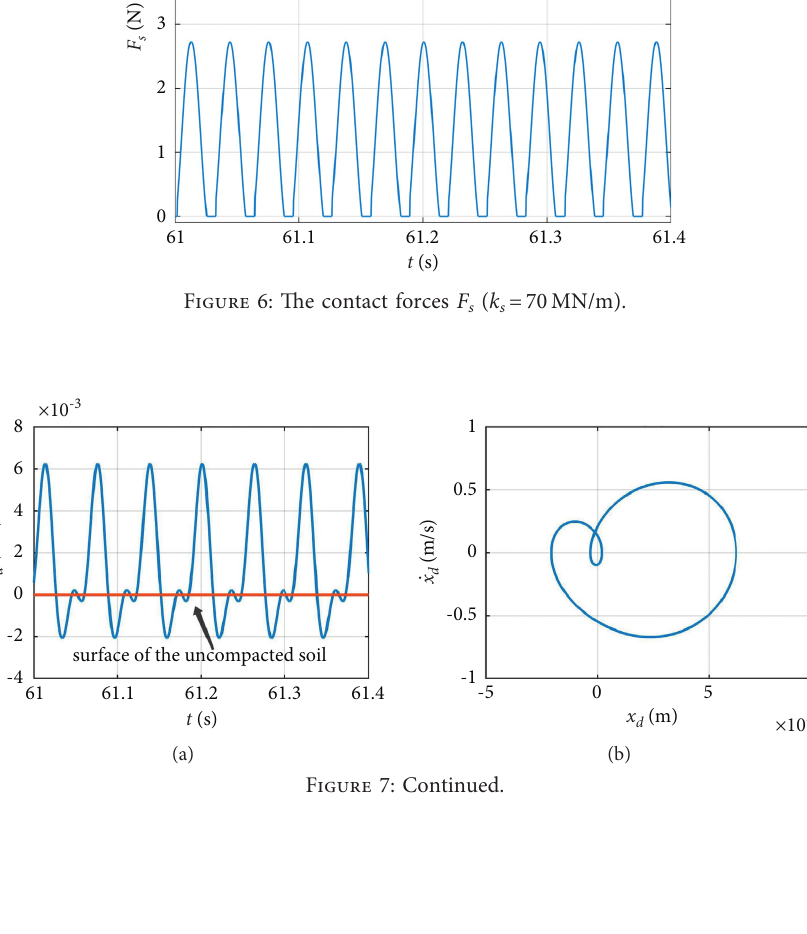
Figure 5: Dynamic responses of the rigid drum ( k Poincare